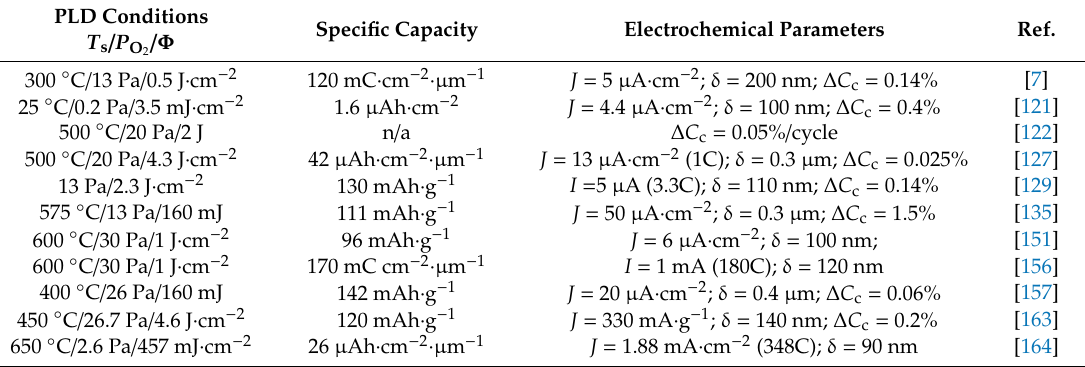
Table 6. Electrochemical properties of PLD-prepared LMO thin film electrodes. J is the current density, δ is the film thickness, and ∆ C c is the capacity fading per